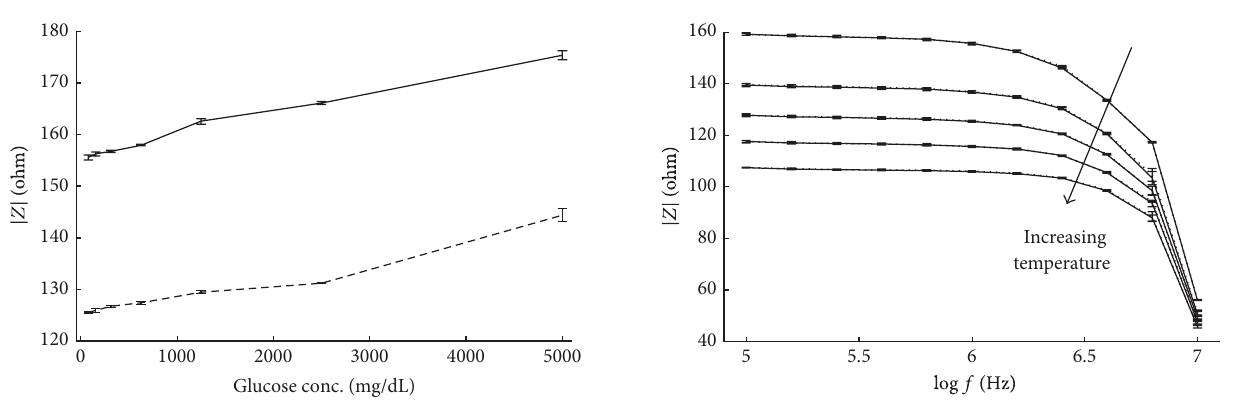
F 4: Impedance modulus of the samples as a function of glucose concentration at 1MHz. Results at the two different tem- peratures are shown: solid curve: room temperature; dashed curve: C. Data reported are mean SE. 37 ∘ ±